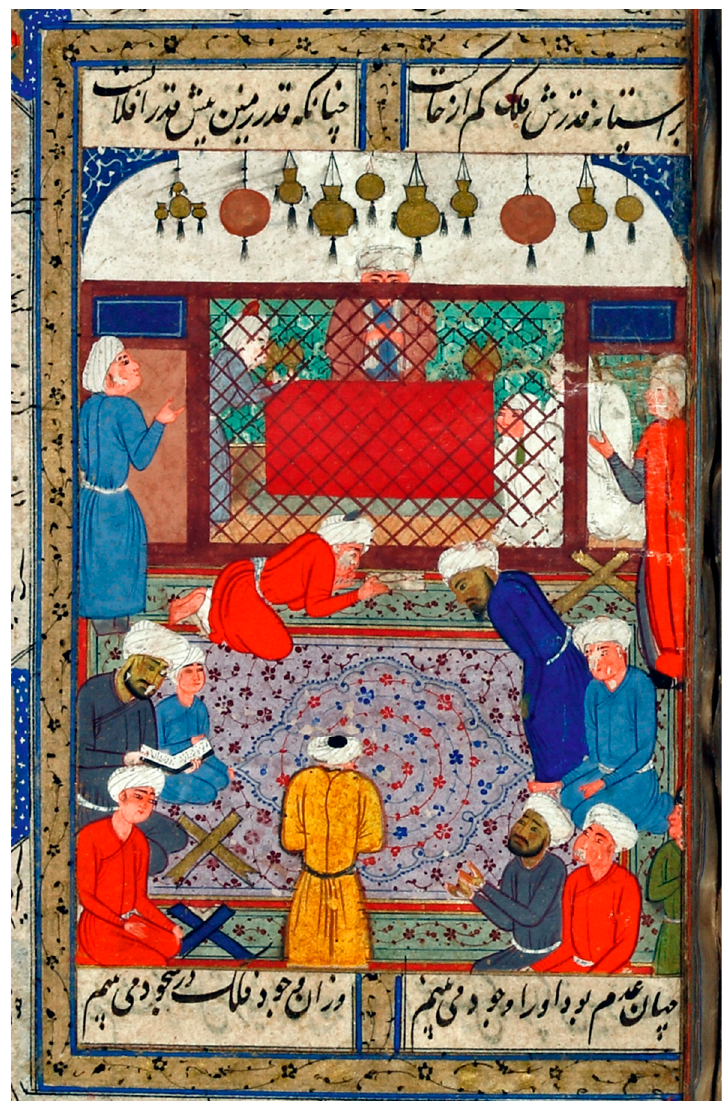
Figure 5. A typical shrine layout, a depicted in a c. 1550 copy of Kulliyat-i Mawl ā n ā Ahl ī Shir ā z ī : While this image hails from the Safavid world, it nicely reflects architectural conventions and practices common to the Ottoman lands. Note the presence of women alongside men behind the grill marking the saint’s tomb. David Collection, Inv. no. Isl 161.